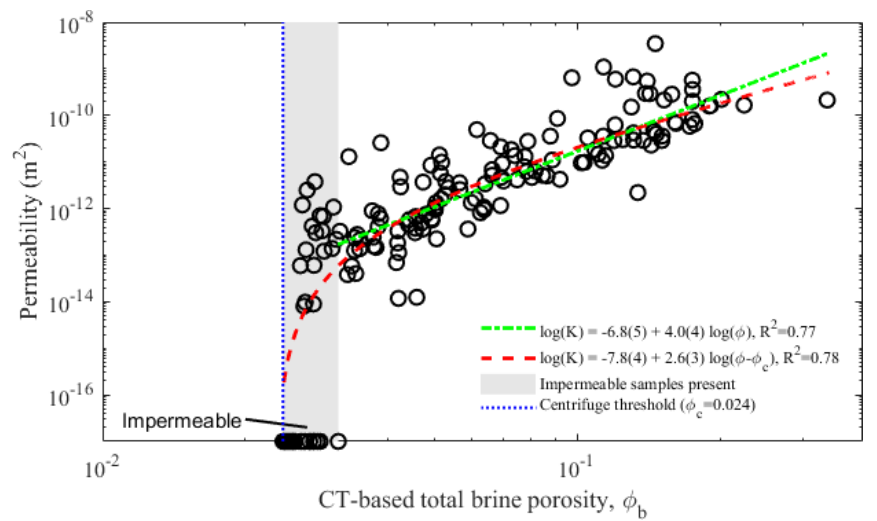
Figure 7. Relationship of simulated vertical permeability K and the total brine porosity φ . Two log–log fits are drawn and specified in the legend, corresponding to power laws of the form K = a(φ) b (green curve) and K = a(φ − φ c ) b (red curve). The numbers in brackets are the uncertainties in the last decimal of the log–log least-squares fit. The grey shading indicates the regime where permeable and impermeable samples are